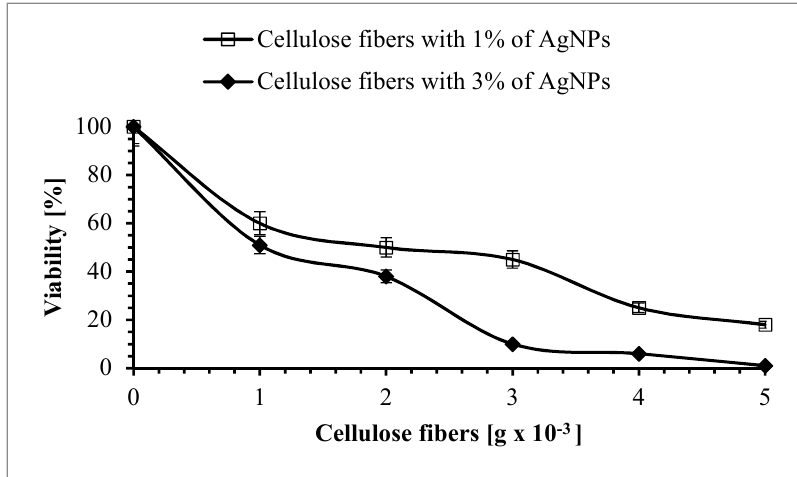
Figure 15. The effect of cellulose fibers modified with AgNPs on the viability of Staphylococcus aureus .